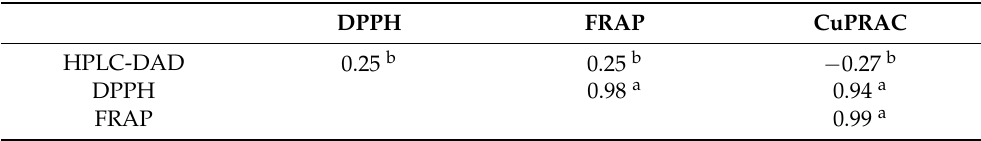
Table 4. Pearson correlations coefficients (R) between the sum of individual phenolics obtained by HPLC-DAD and the antioxidant values obtained by DPPH, FRAP, and CuPRAC assays. DPPH FRAP CuPRAC HPLC-DAD 0.25 b 0.25 b − 0.27 b DPPH 0.98 a 0.94 a FRAP 0.99 a Different superscript letters ( a and b ) indicate significant differences at p -value <